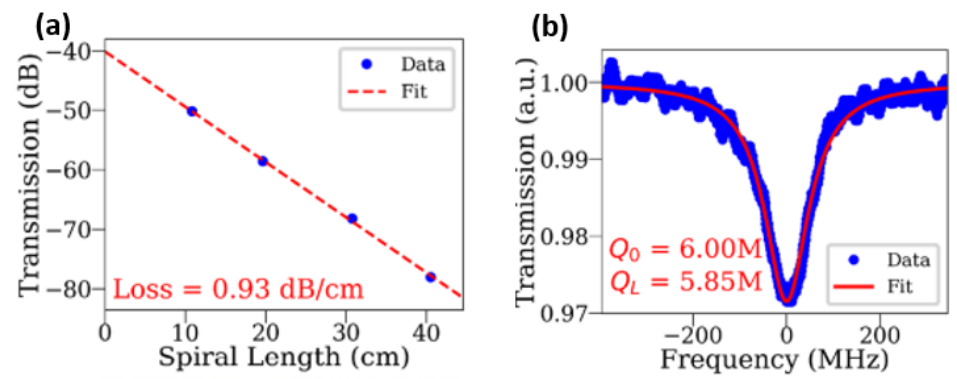
Figure 10. ( a ) Cutback measurement results for 0.8µm wide waveguide spirals of around 405nm and ( b ) measured transmission spectra of a high-Q mode at 453nm; reprinted with permission from [240], ©2021 The Optical